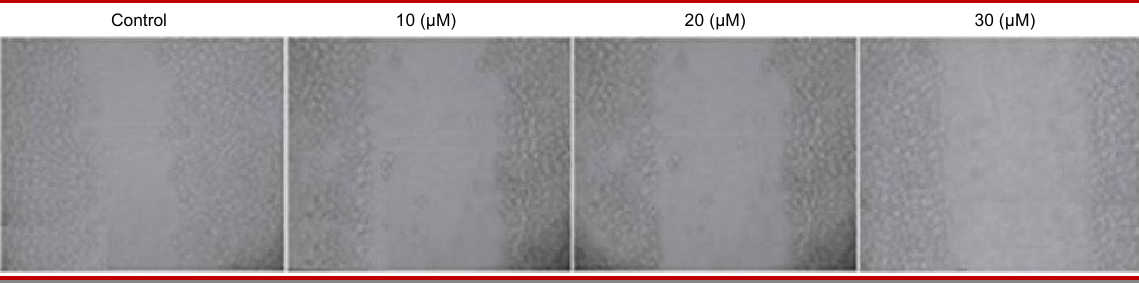
Figure 3. Effect of ludartin at various concentrations on migration potential of OVCAR5 cells. The cells after ludartin treatment were analyzed for cell migration using wound healing assay. b p<0.05 compared with the control